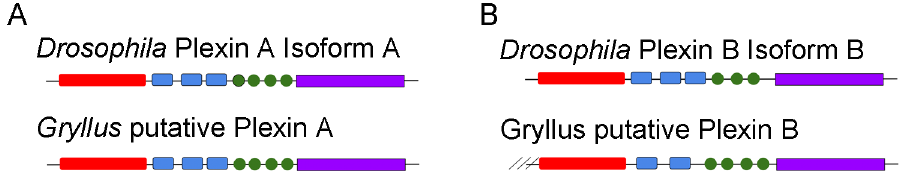
Fig 6. Plexin proteins predicted from the G . bimaculatus transcriptome share most of the functional domains found in Drosophila Plexin proteins. A) The type, number, and order of protein domains was assessed using Drosophila Plexin A, isoform A (AAF59394) and the putative G . bimaculatus Plexin A (TRINITY_DN159247_c0_g1_i2) as queries in a conserved domain search. Both proteins possessed a sema domain (red rectangle), three plexin repeats (blue rectangle), four IPT domains (Ig, Plexin Transcription factor domains; green circles), and a rasGAP domain (purple rectangle). B) The type, number, and order of protein domains was assessed by using Drosophila Plexin B, isoform B (AFH06760) and the putative G . bimaculatus Plexin B (TRINITY_DN161683_c0_g1_i2) as queries in a conserved domain search. Both proteins possessed a Sema domain (red rectangle) two or three plexin repeats (blue rectangles), three or four IPT domains (Ig, Plexin Transcription factor domains; green circles), and a rasGAP domain (purple rectangle). Diagonal lines indicate sequence missing from the N-terminal end of the G . bimaculatus